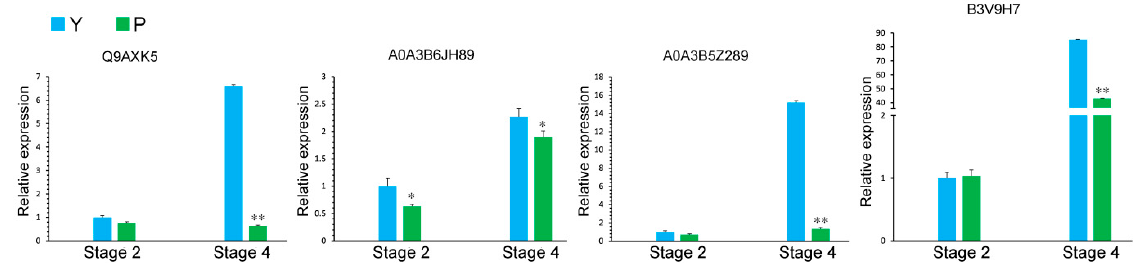
Figure 12. Relative expression of related genes sucrose synthase (A0A3B6JH89), sucrose-6F-phosphate phosphohydrolase SPP2 (Q9AXK5), Phosphotransferase (A0A3B5Z289), and starch synthase (B3V9H7) during anther development in starch and sucrose metabolism. Y (maintain line), P (sterile line). Stage 2: Early uninucleate stage; Stage 4: Binucleate stage. The data were statistically analyzed by Student’s t ‐ test (* p < 0.05; ** p < 0.01).